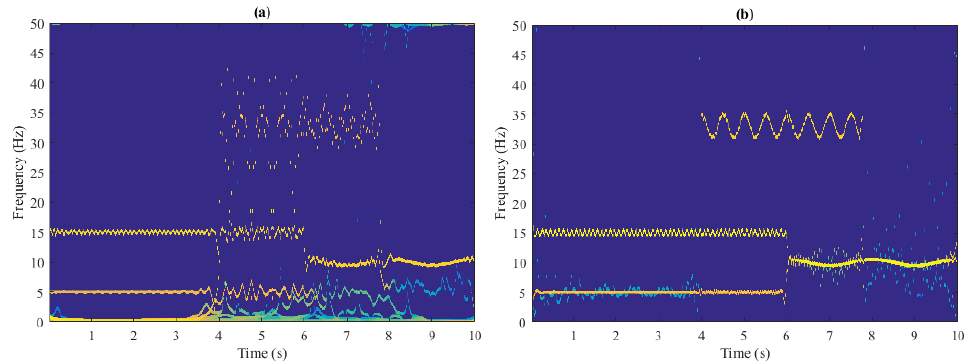
Figure 6. The instantaneous spectrum based on ( a ) EMD and ( b ) VMD.